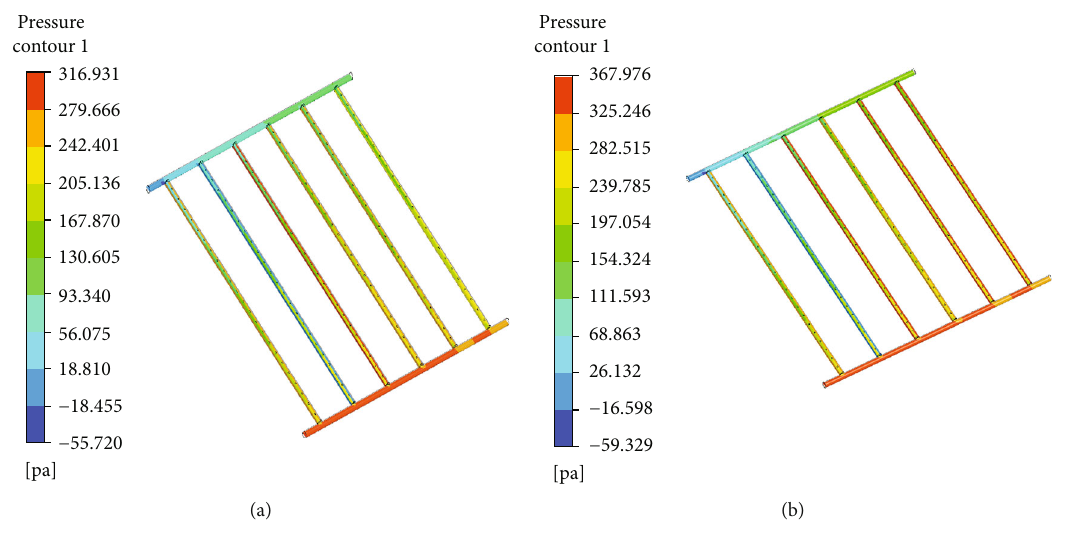
Figure 6: (a) Low-pressure contour. (b) High-pressure contour.